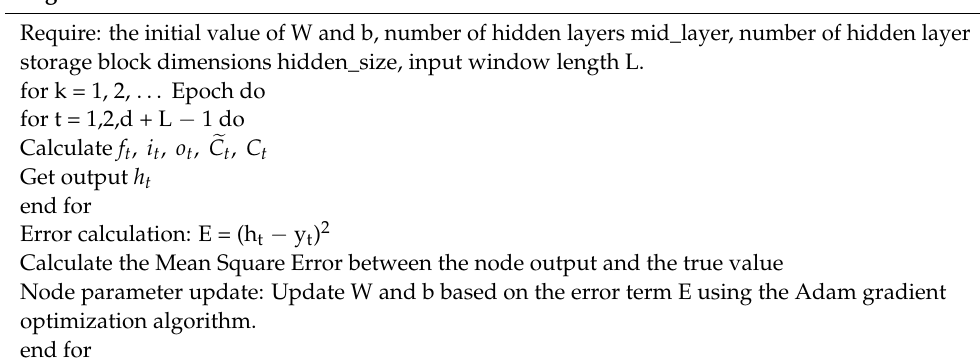
Algorithm 1: LSTM model iteration